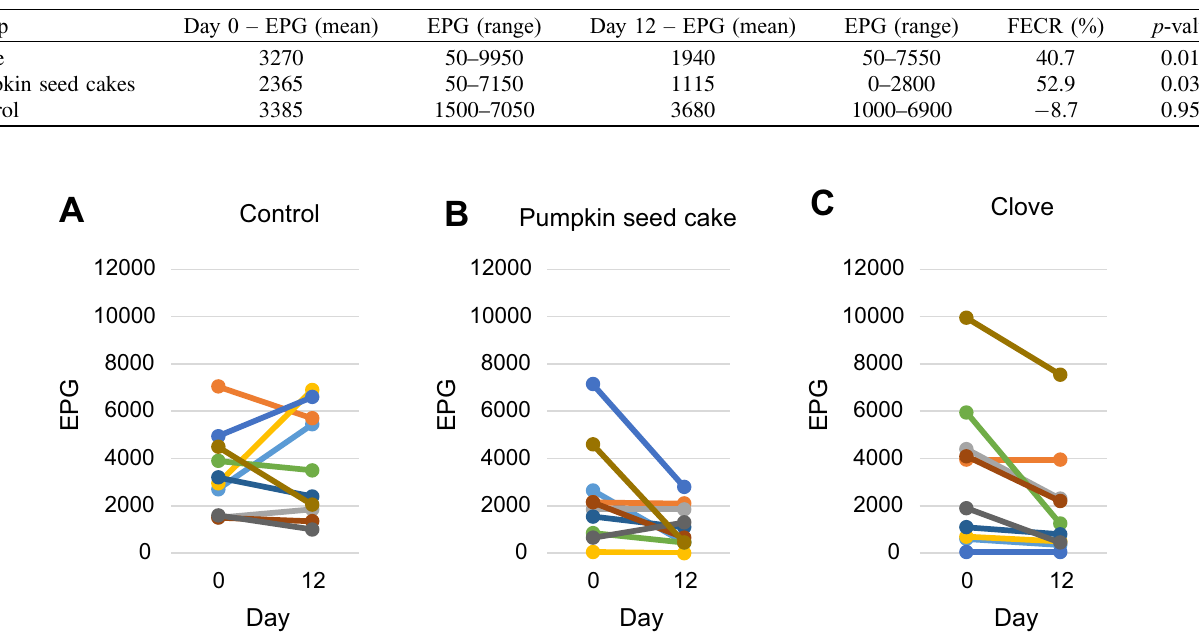
Figure 1. The results of Strongylid faecal egg counts in the control (A), pumpkin seed cake (B) and clove (C) group (the lines represent individual